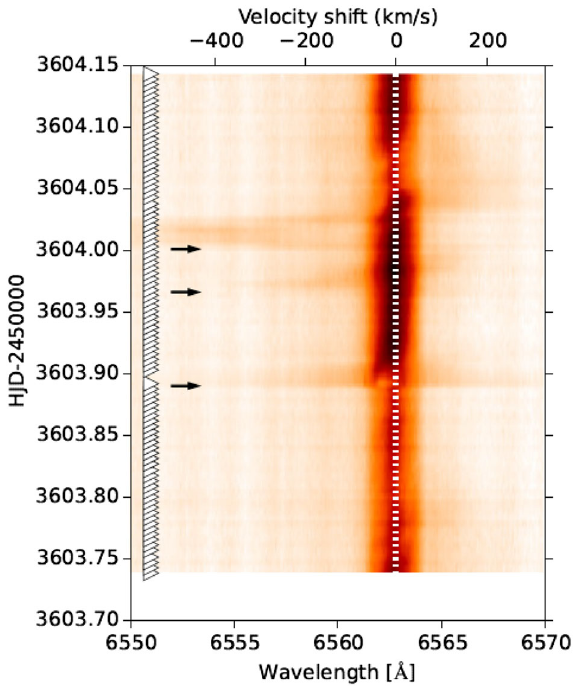
Fig. 37 Blue-wing enhancements (shown by arrows) in dynamic H α Balmer line spectra of a fully- convectiveM4dwarfstarV374Pegasusoccurred.Thedarkeningcoloursindicatetheincreasingintensityof theH α region.TheverticalaxisshowsthetimeinHeliocentricJulianDays(HJD),startingfrom2453603.70. Image reproduced by permission from Vida et al. (2016), copyright by ESO